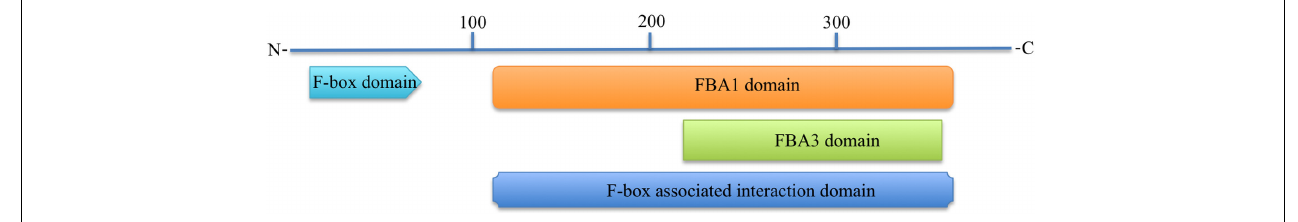
FIGURE 7 | Predicted functional domains in 3p.AtFBP113 protein sequence. The figure depicts that 3p.AtFBP113 sequence contains two main domains one residing in its N-terminal region, whereas the other is present at the C-terminal region. Though different C-terminal domains are predicted from different domain prediction databases but these have overlapping regions and belong to the same subclass of F-box proteins, i.e., F-box associated domain (FBA).